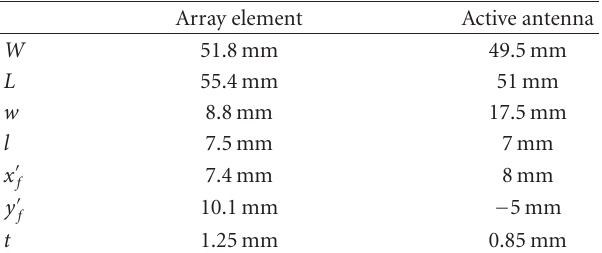
Figure 3: Geometry of the active receive antenna. Table 1: Dimensions of the individual transmit array elements and active receive antenna